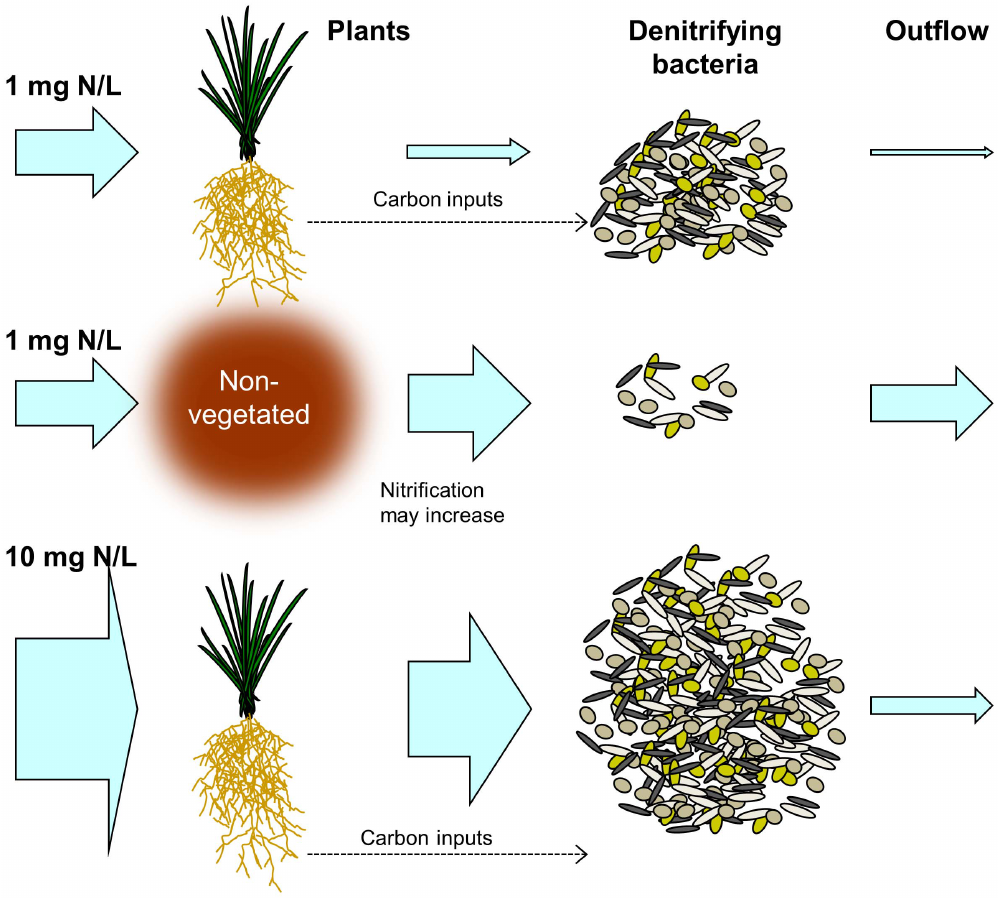
Figure 7. Conceptual diagram illustrating nitrate processing. Removal by assimilation and denitrification at different nitrogen loadings in vegetated and non-vegetated systems. The dependence of denitrifying bacteria on plant-derived carbon is also represented.